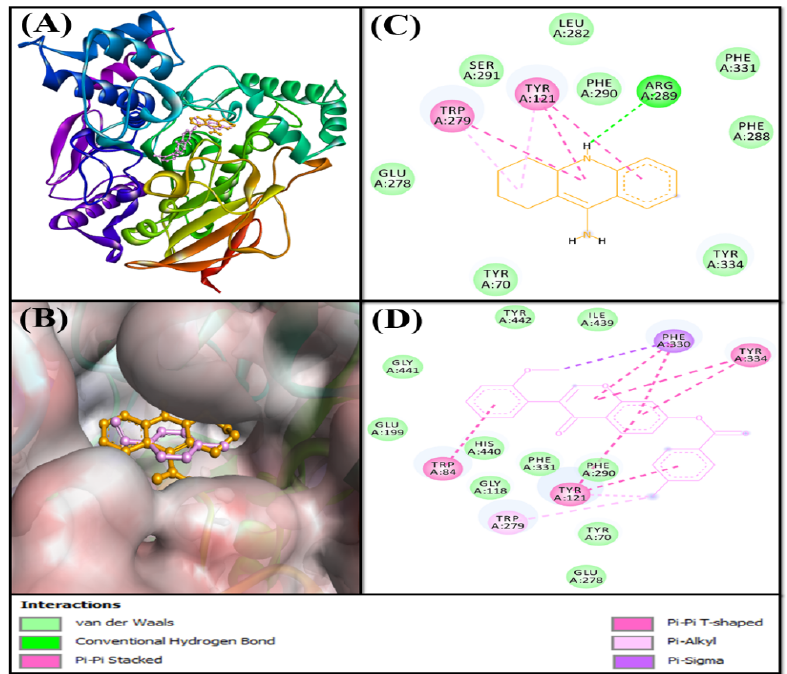
Figure 1. Interaction of target protein, AChE with F0850-4777 and their respective control ligands. ( A ) Position of F0850-4777 and Tacrine in AChE. ( B ) Interactions between AChE and Tacrine. ( C ) Superimposed image of F0850-4777 and Tacrine in AChE. ( D ) Interactions between AChE and F0850-4777.